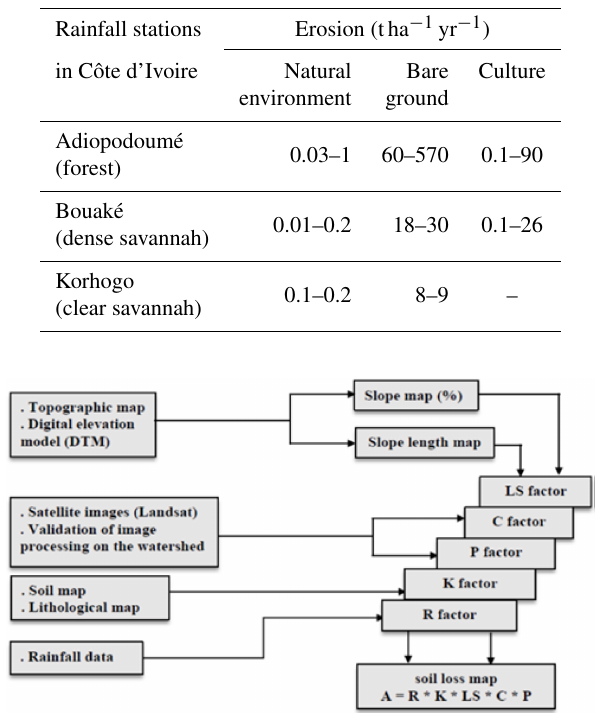
Figure 4. Methodology for estimating soil loss (Meliho et al., 2016).